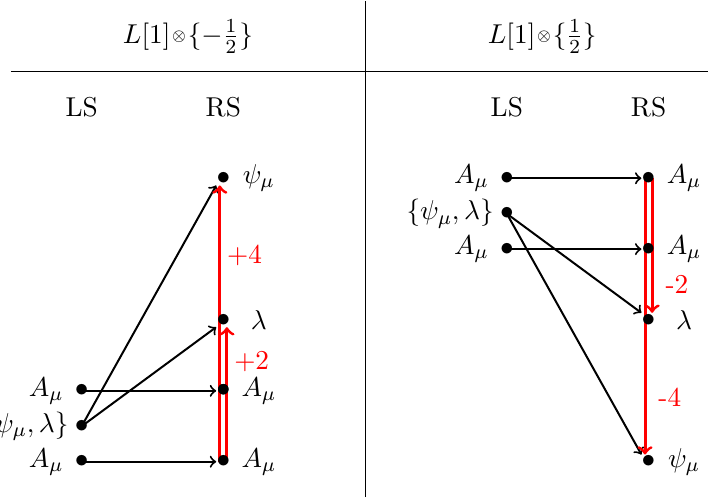
Figure 5 . Shift patterns of the conformal dimensions of the states within L [1] , as we go from the left- to the right-squashed S 7 . Here, A µ are vectors, ψ µ is a gravitino, and λ a fermion with spin 1